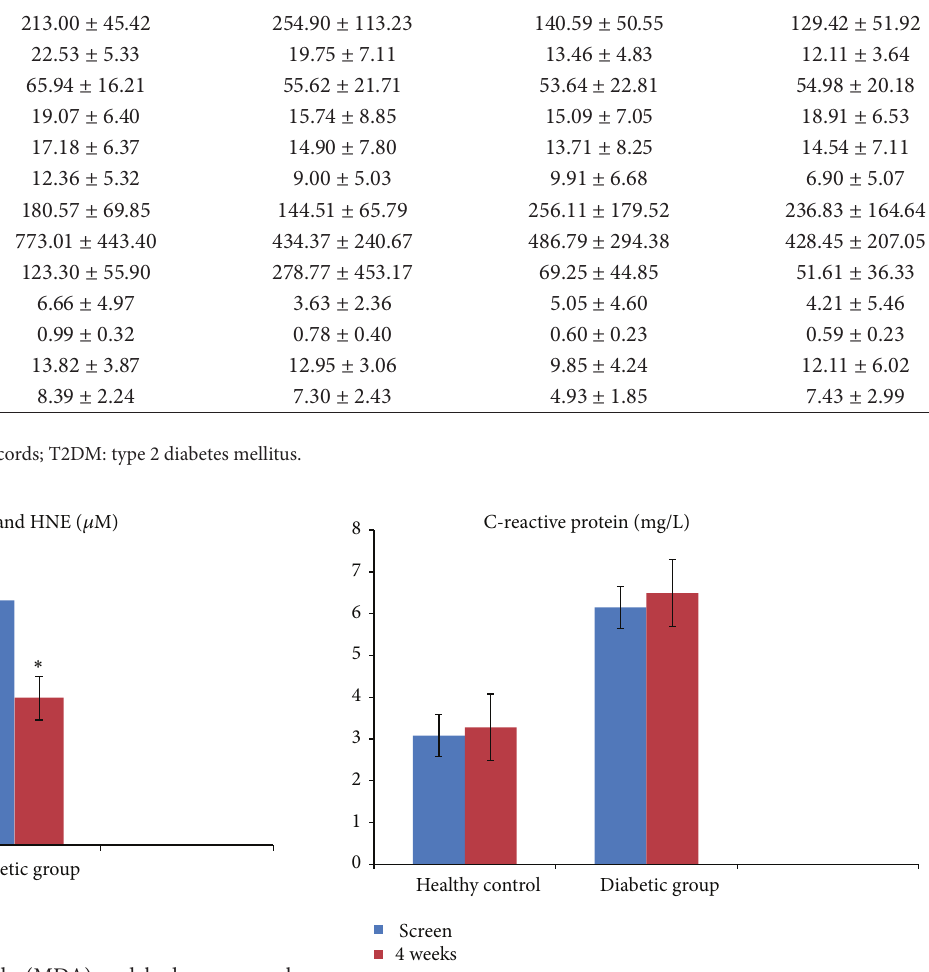
Figure 2: Serum malondialdehyde (MDA) and hydroxynonenal (HNE) in healthy controls ( 𝑛 = 9 ) and in patients with type 2 diabetes ( 𝑛 = 8 ) before and after (4 weeks) pomegranate polyphenol supplementation. Data presented as mean ± SD. ∗ Significantly different from baseline at 𝑃 < 0.05 .